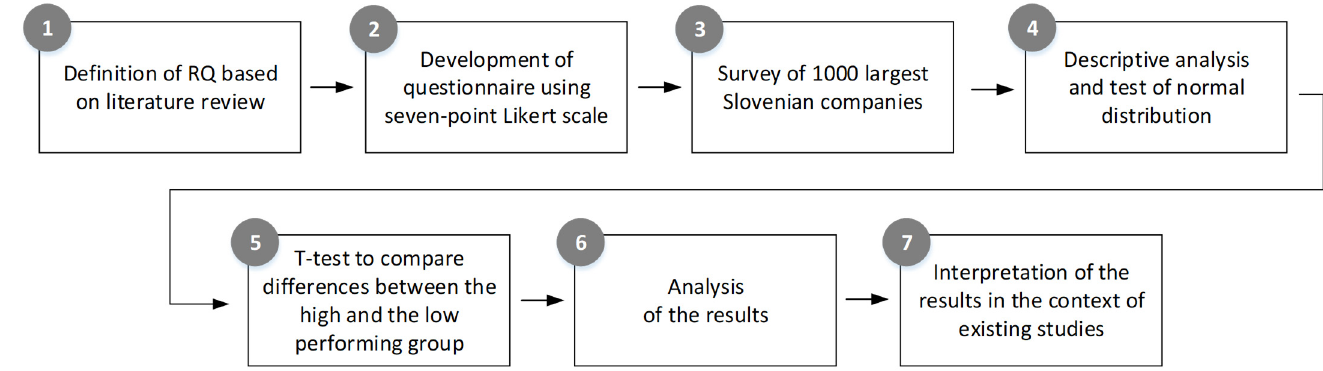
Figure 1. The key steps of our study.